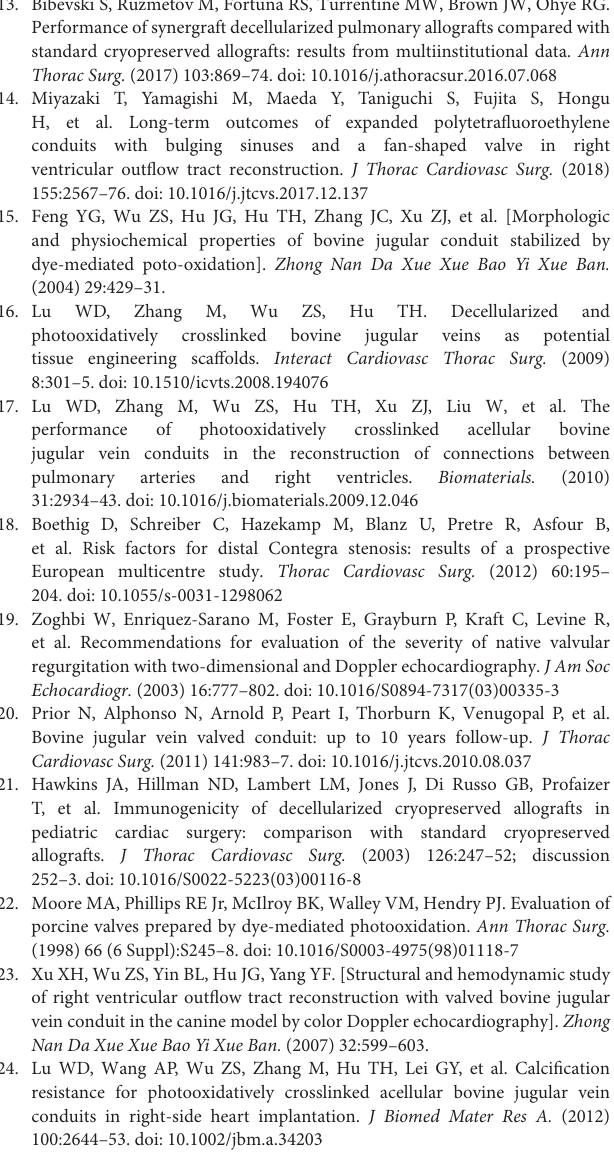
transposition of the great arteries, showing the normal-sized heart and unobstructed ventricular outflow tracts. Supplementary Figure 4 | Severe aneurysmal dilatation of DP-BJVC in a 3.5 years old girl. The conduit was reinforced with a Dacron ring. However, the diameter dilated almost 170% (from 12 to 20mm) after 23 months at the level of annulus, which was even larger at the proximal and distal level. Although the conduit is currently in a undesirable state due to the extremely heavy afterload, it indirectly reflect that the annulus restraining device does not strictly limit the diameter of the conduit. Supplementary Figure 5 | The results of comparison of diameter change between reinforced and non-reinforced DP-BJVC. The change of diameter significantly and positively linear correlated with follow-up time both in non-reinforced and reinforced conduit, with regression coefficient (slopes) of 0.53 and 0.48 respectively. The differences between the slopes are not significant ( P =